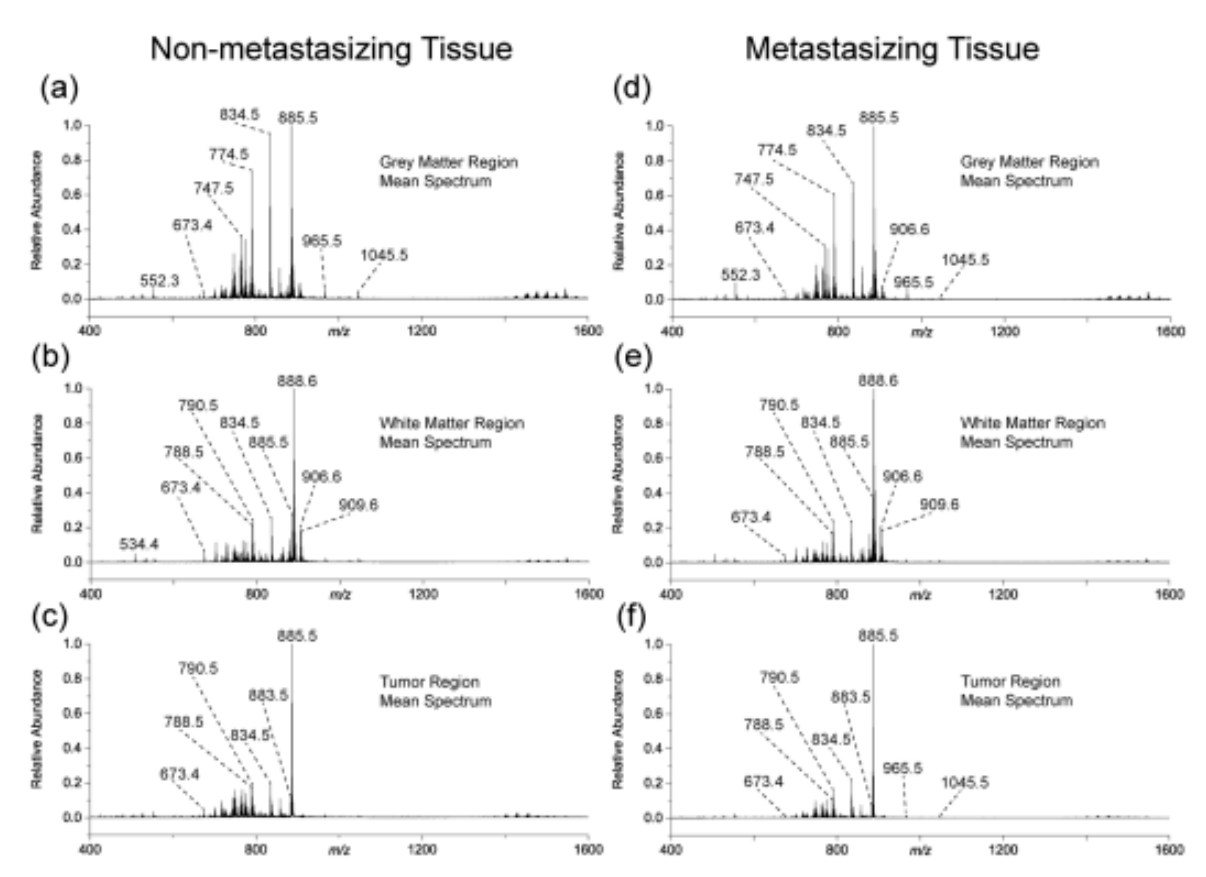
Figure 5. The calculated mean spectra for tumor regions mouse brain containing a non-metastasizing medulloblastoma primary tumor ( a – c ) and tumor regions in a mouse brain containing a metastasizing medulloblastoma primary tumors ( d – f ). (From Paine et al., Sci. Rep. 2019).